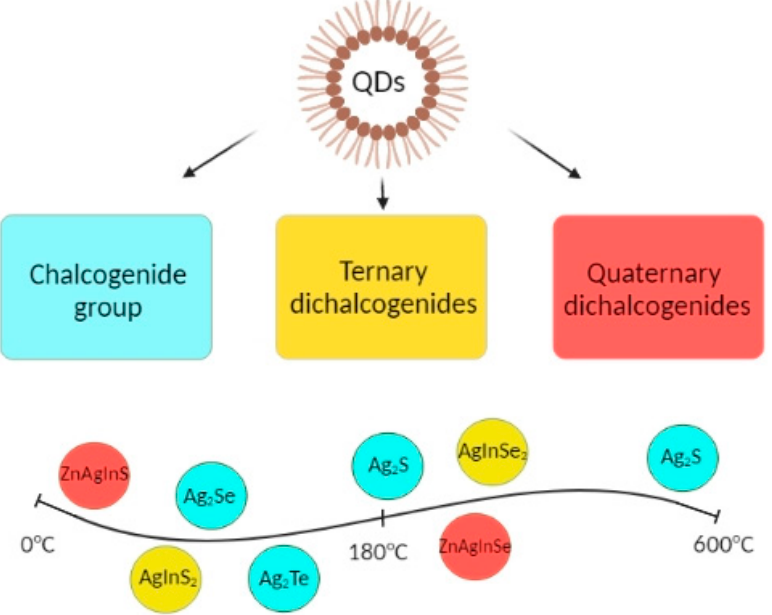
Figure 2. Schematic diagram of main types of Ag-based QDs.